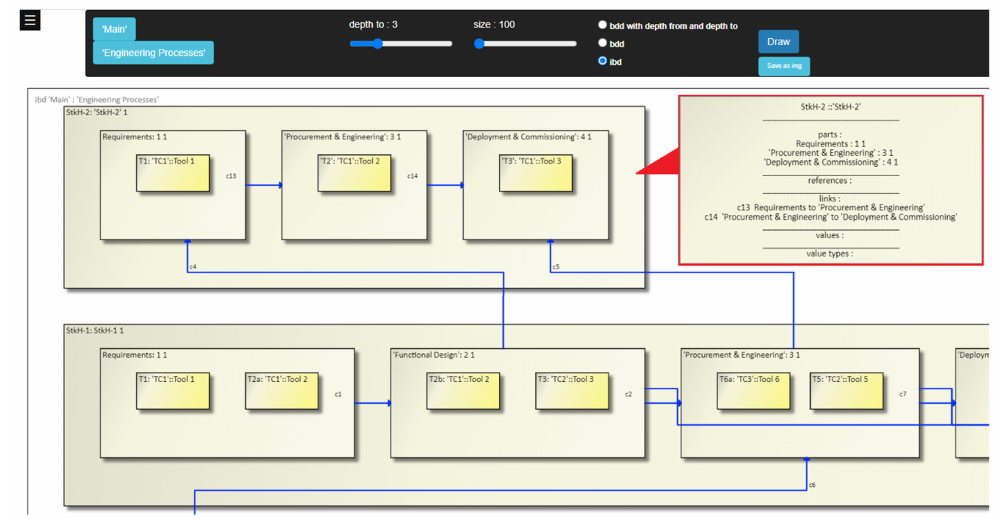
Figure 5. The web tool developed to represent multilayer Arrowhead-EPs of several stakeholders involved in the system life cycle. We focus on part of the Arrowhead-EP schema of Figure 4, highlighting the interaction between StkH1 and